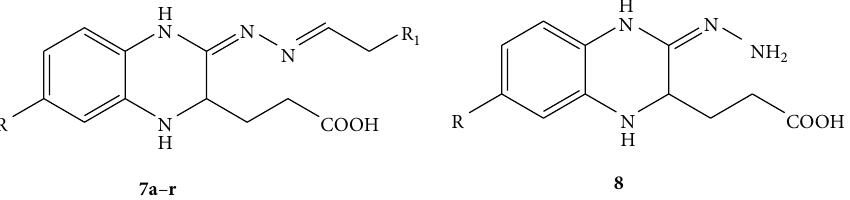
Scheme 1: Synthesis of compounds 10a – g .